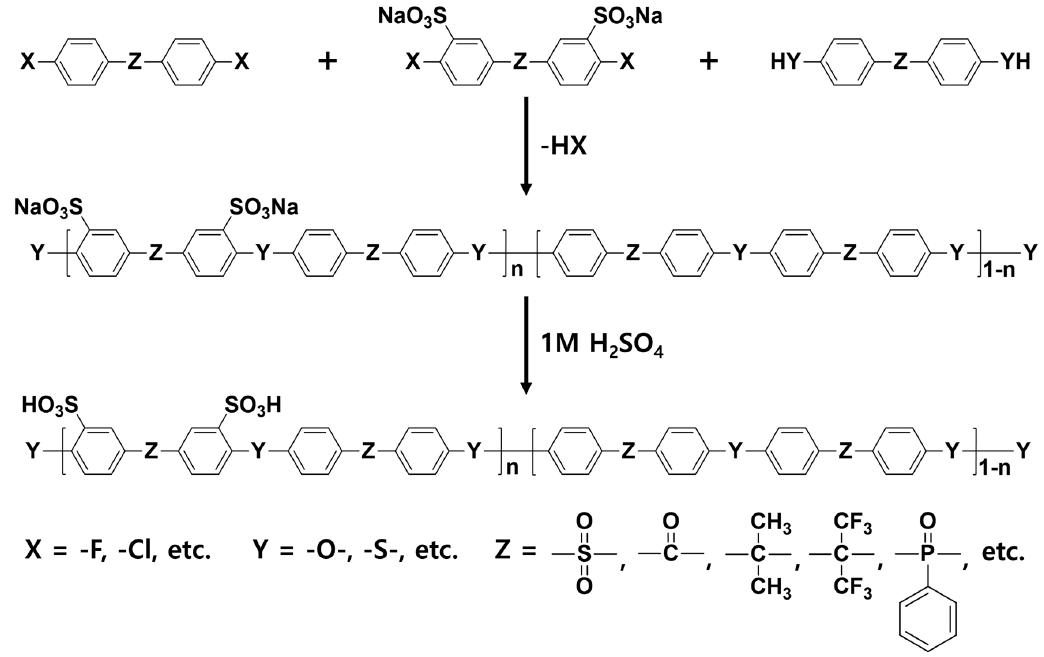
Figure 3. Synthetic procedures of sulfonated hydrocarbon-based random copolymers.